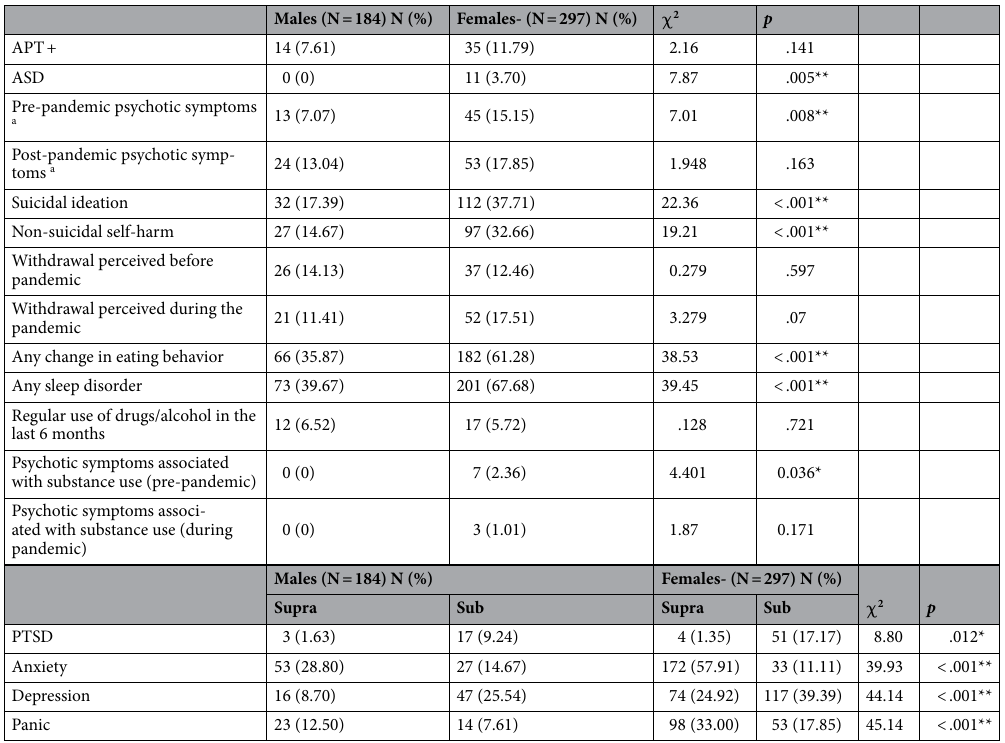
Table 4. Comparison between gender. Significance: * ≤ 05 ; ** ≤ .01. a Not due to substance